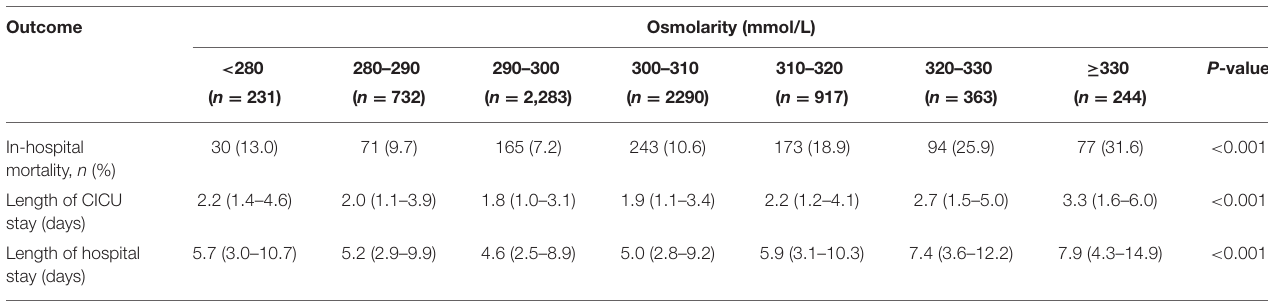
TABLE 2 | Outcomes by osmolarity categories in CICU